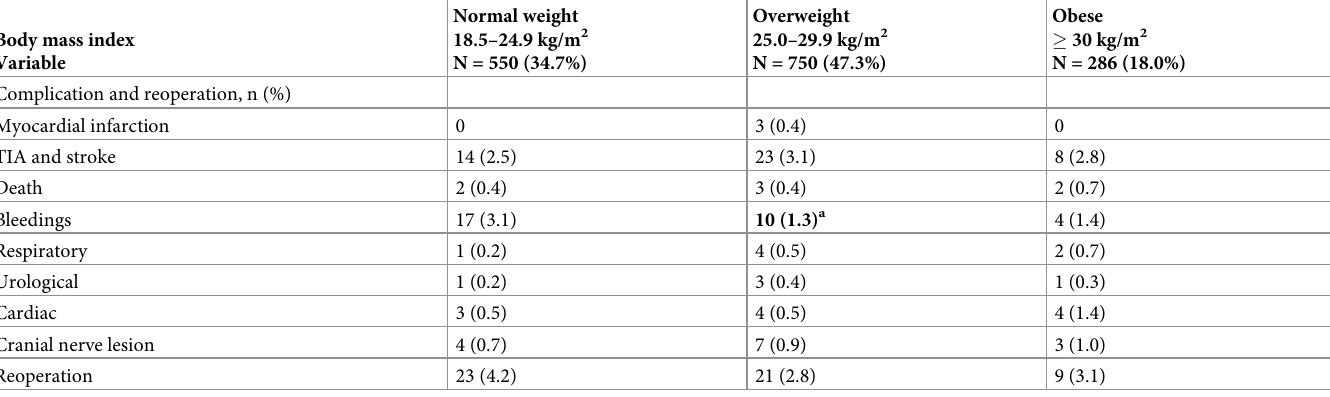
Table 3. Perioperative (30-day) outcomes � .